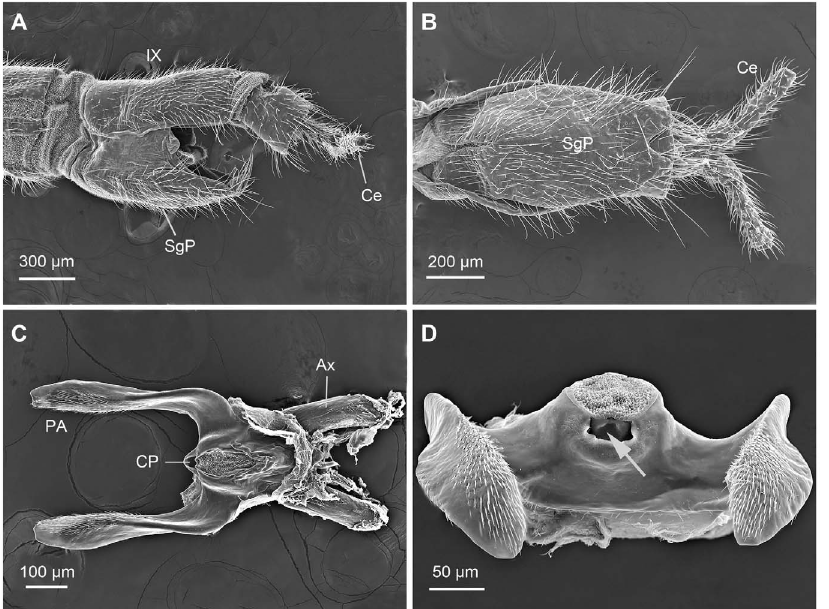
Figure 7. Female genitalia of N.longiprocessa . (A) Abdominal segments VIII–XI, lateral view. (B) Abdominal segments IX–XI, ventral view. (C) Genital plate, ventral view. (D) Same, caudal view, arrow showing the copulatory pore (orifice of the spermathecal duct). Ax, axis; Ce, cercus; CP, copulatory pore; PA, posterior arm; SP, subgenital plate.